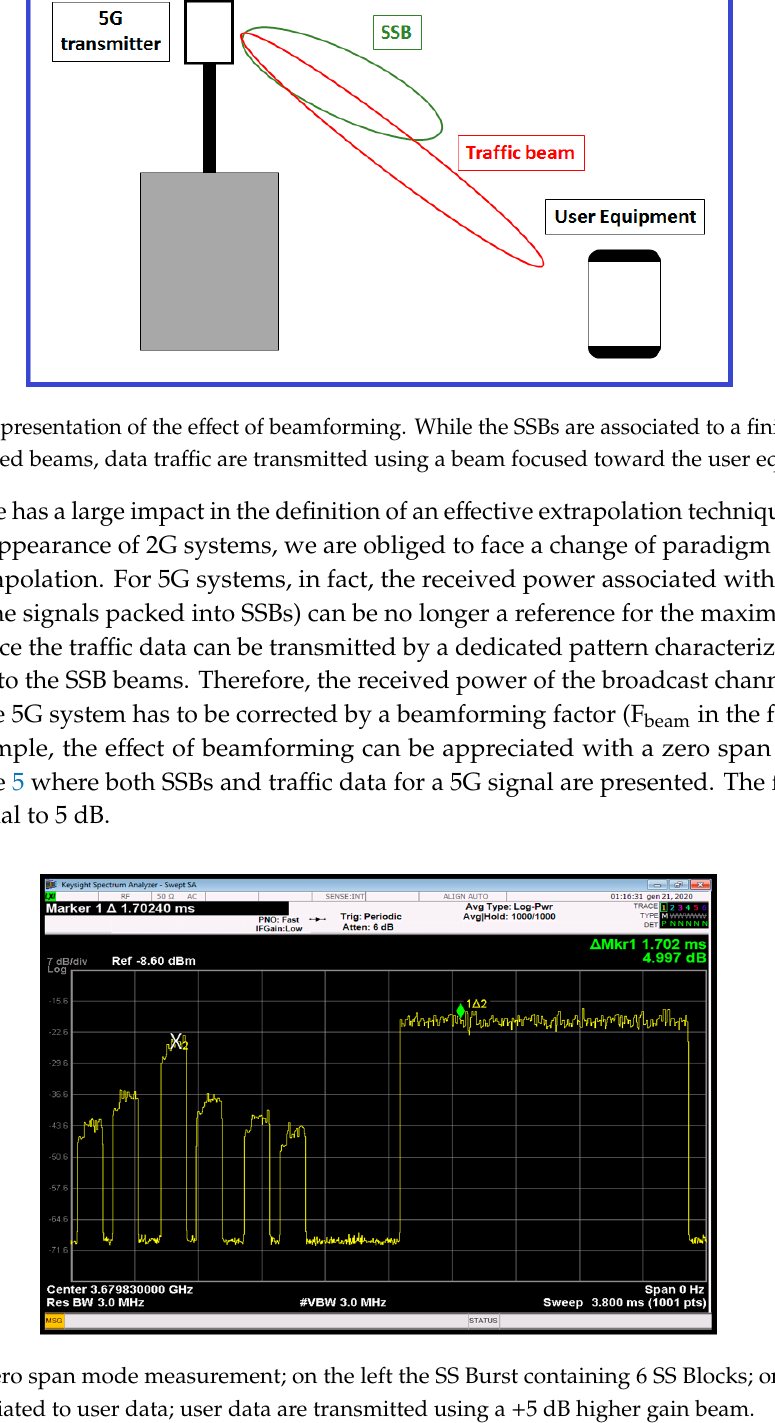
Figure 5. Zero span mode measurement; on the left the SS Burst containing 6 SS Blocks; on the right, signal associated to user data ; user data are transmitted using a +5 dB higher gain beam.